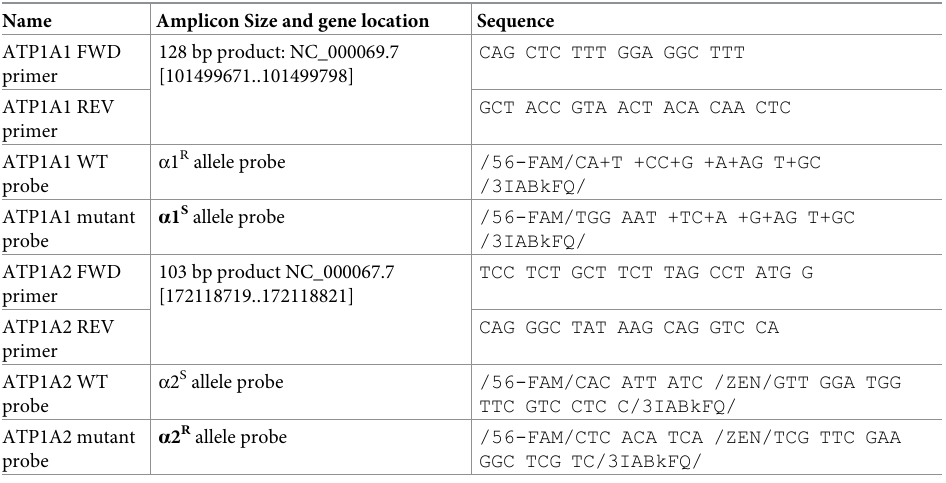
Table 2. Primers and probes.